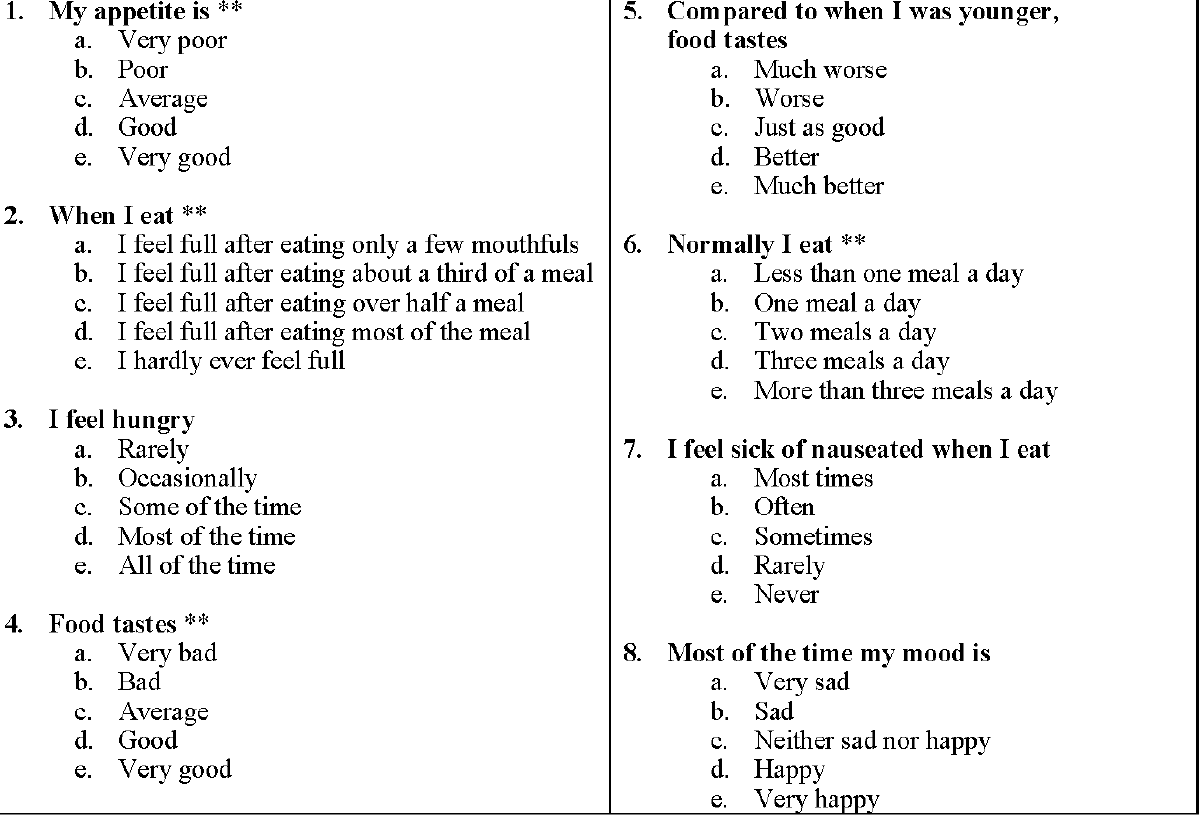
Figure 1. The Council on Nutrition Appetite Questionnaire (CNAQ) and the Simplified Nutritional Appetite Questionnaire (SNAQ) tools used in the randomised controlled trial of elderly ambulatory rehabilitation patients